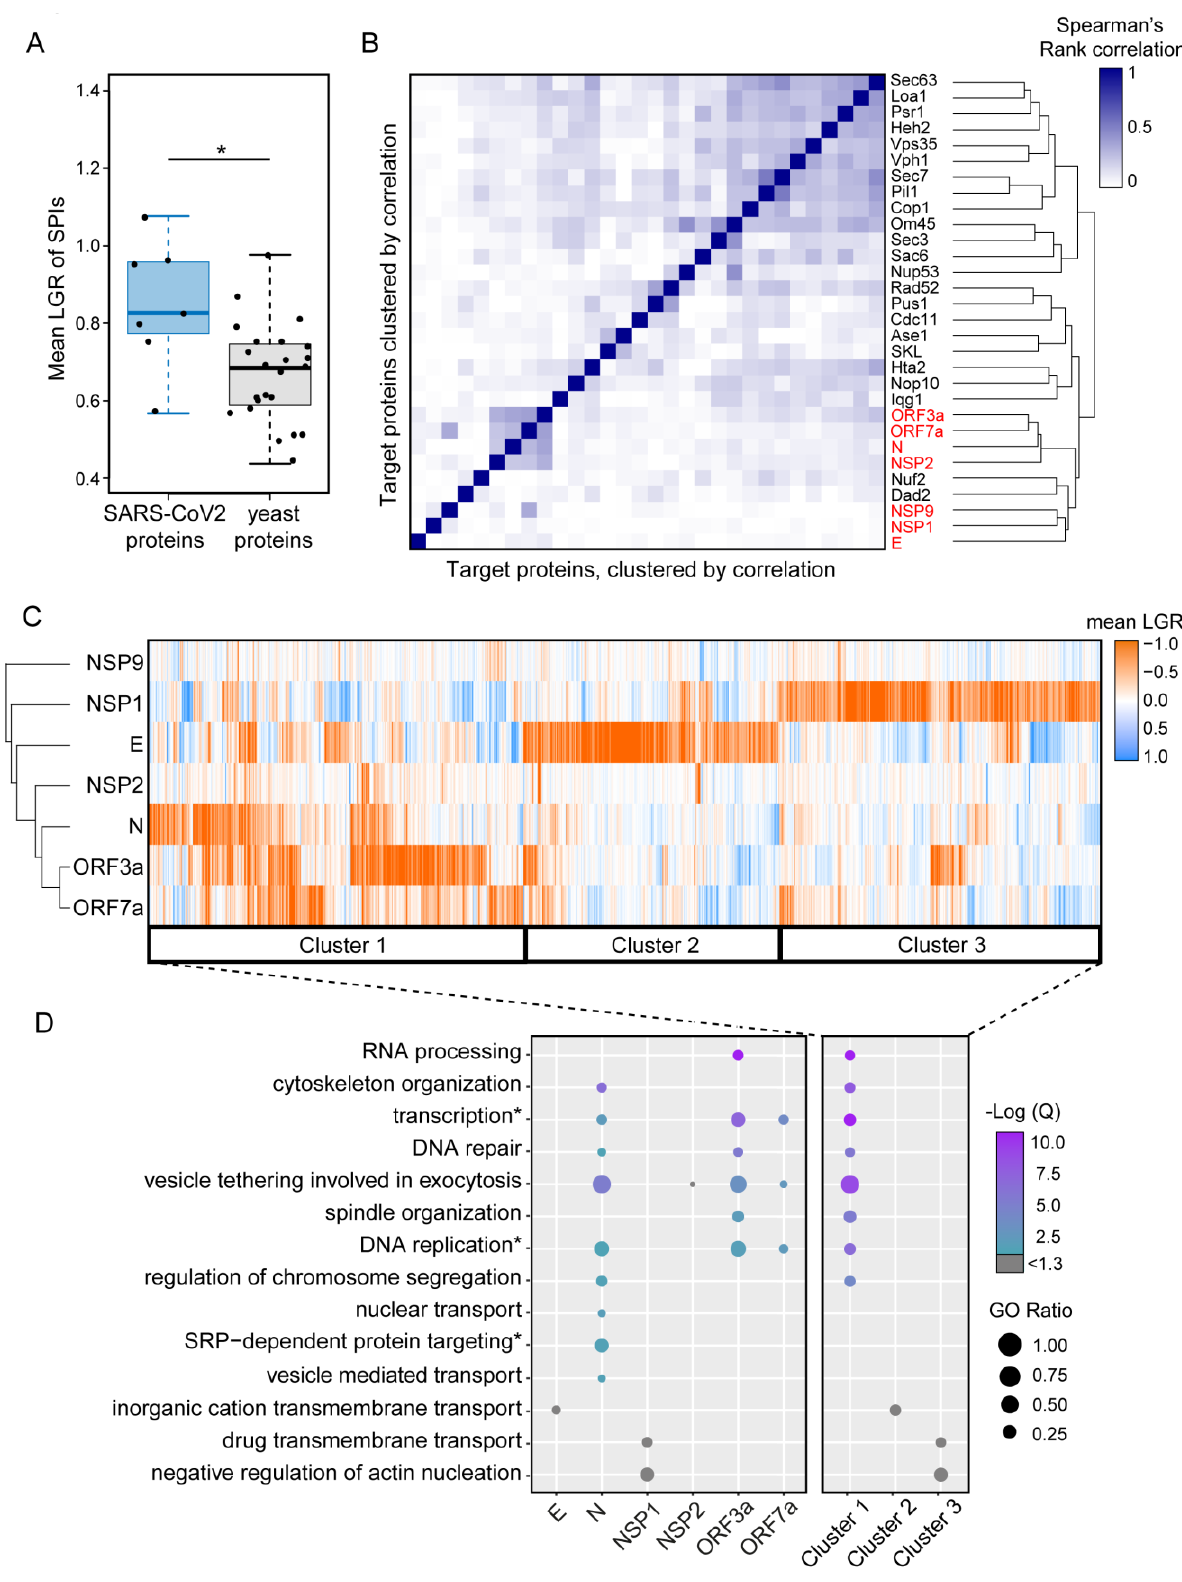
FIGURE 3: Clustering of SPIs from SARS-CoV-2 screens and yeast screens. (A) Compared to previous SPI screens which use yeast proteins of interest, the SARS-CoV-2 SPIs, on average, have higher LGRs. Statistical significance was assessed using Welch’s two sample t-test (the two as- terisks, * indicate a p-value of = 0.029). Boxplot parameters are as in Figure 1D. (B) Hierarchical clustering of Spearman's rank